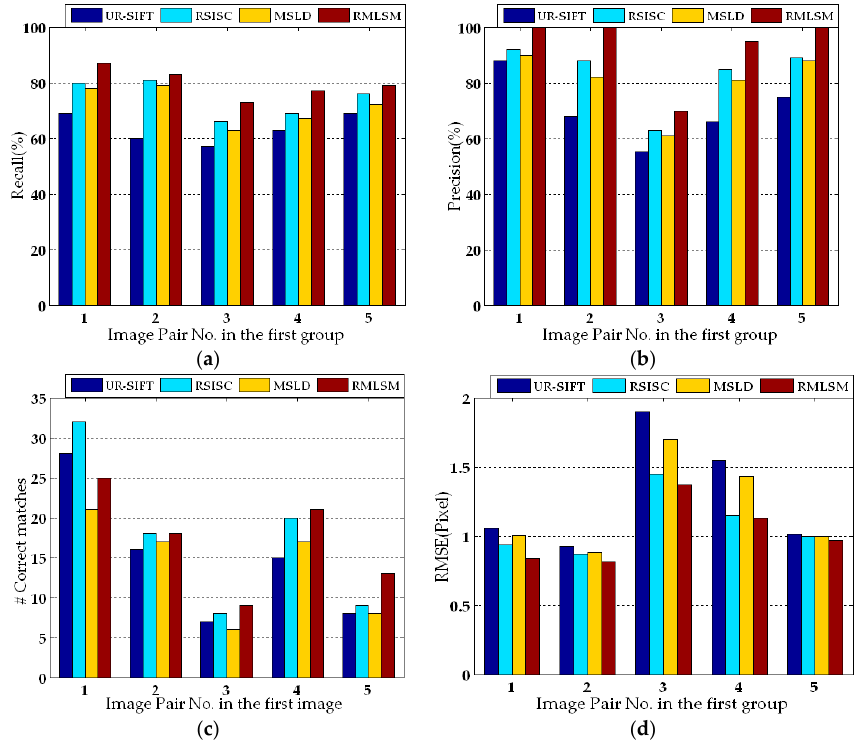
Figure 10. Experimental results on the simulated image pairs. ( a ) Recall; ( b ) precision; ( c ) correct matches; ( d ) RMSE.UR-SIFT, uniform robust scale-invariant feature